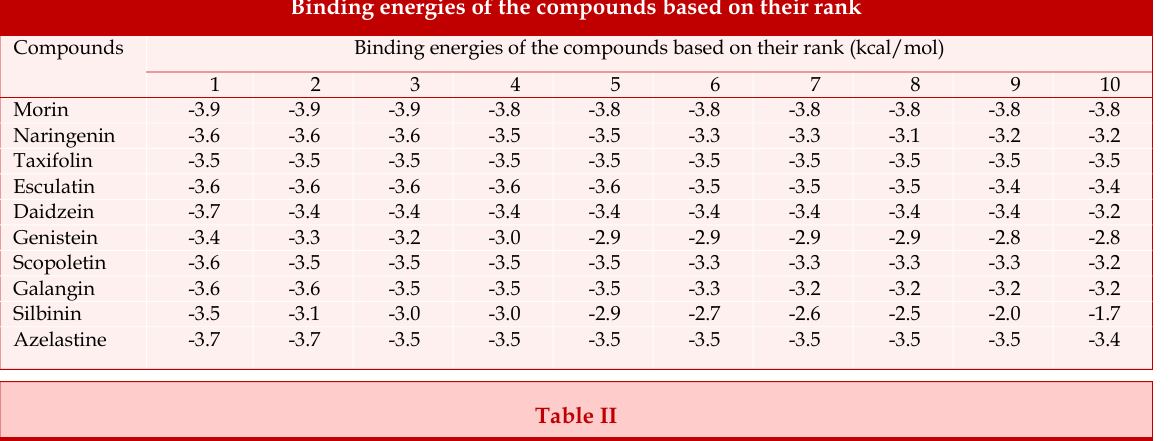
Inhibition constant of the compounds based on their